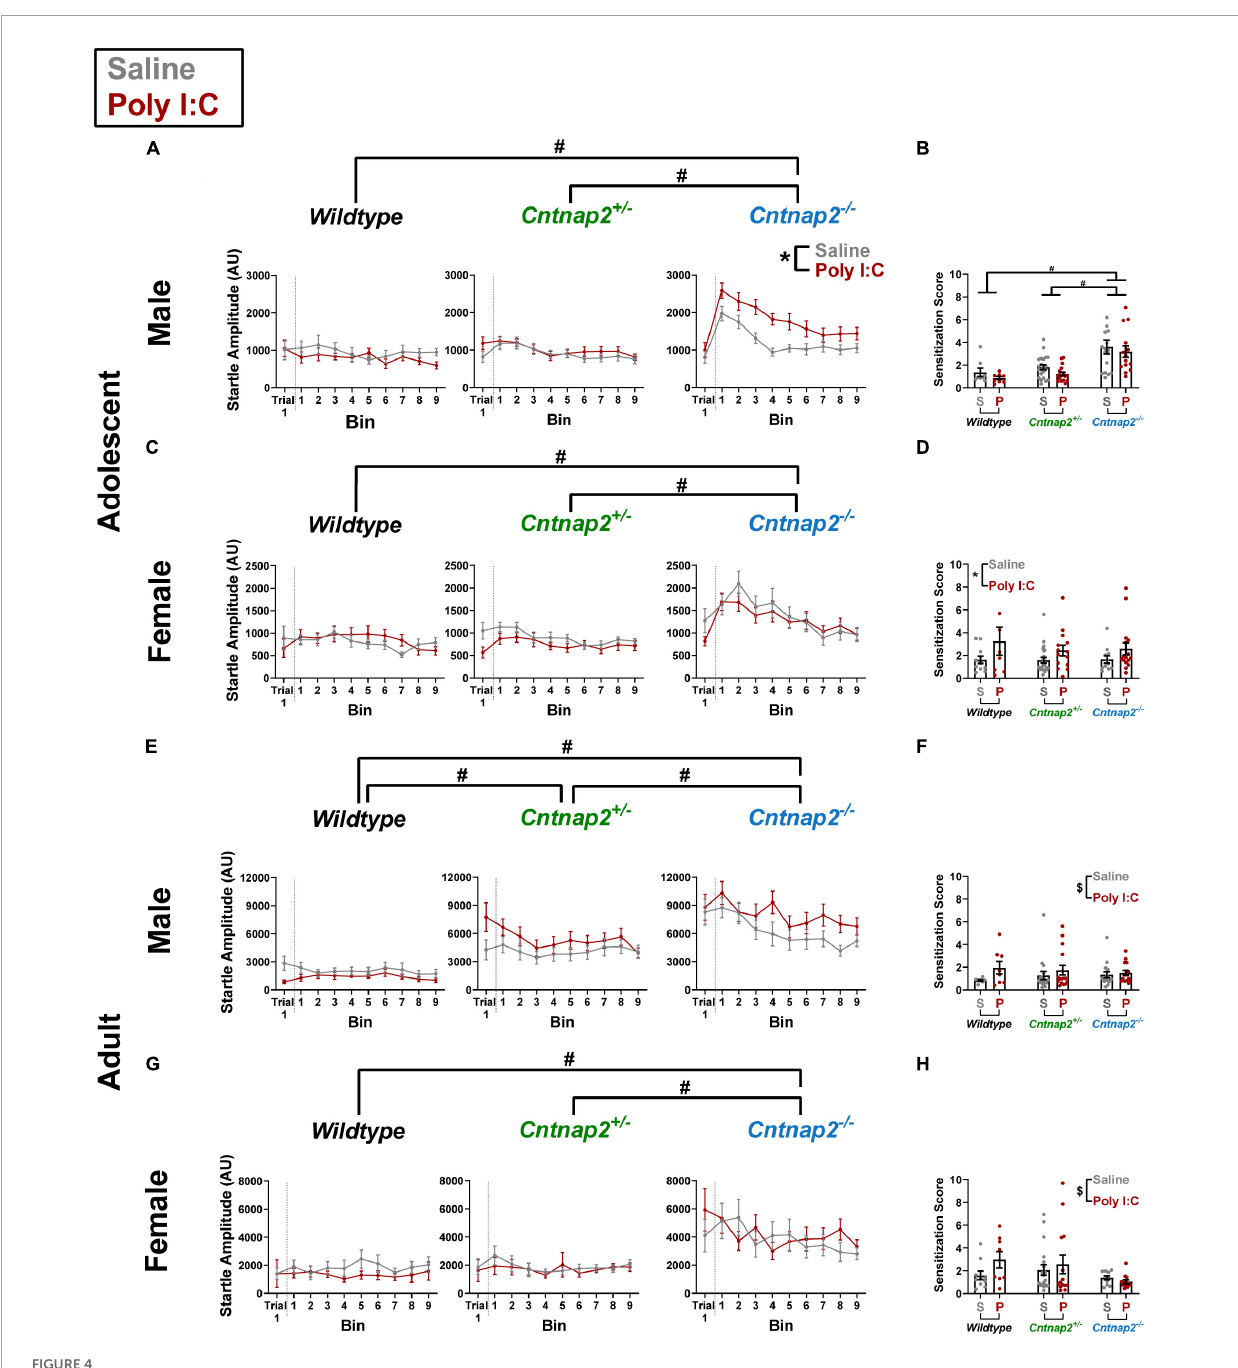
FIGURE4 Independent and synergistic effects of Cntnap2 knockout and Poly I:C MIA on sensitization of startle that manifest in an age, sex, and measurement-specific manner. (A) Adolescent Cntnap2 − / − males show increased startle reactivity compared to both Cntnap2 + / − and WT males across the entire session (adjusted p < 0.001 for both comparisons; independent genotype effect indicated by the # symbol). In addition, Cntnap2 − / − Poly I:C males show increased startle reactivity compared to Cntnap2 − / − saline males ( p < 0.001; synergistic genotype-MIA effect indicated by the ∗ symbol). (B) Sensitization scores show that only the independent genotype effect remains after normalizing the baseline startle response amplitude (adjusted p < 0.001; indicated by the # symbol). (C) Adolescent Cntnap2 − / − females how increased startle reactivity compared to both Cntnap2 + / − and WT females across the entire session (adjusted p < 0.001 for both comparisons; independent genotype effect indicated by the # symbol). (D) Adolescent Poly I:C females show increased sensitization scores compared to adolescent saline females regardless of genotype ( p = 0.04; indicated by the ∗ symbol). (E) Adult Cntnap2 − / − and Cntnap2 + / − males both show increased startle reactivity compared to WT males across the entire session (adjusted p < 0.001 for both comparisons; independent genotype effect indicated by the # symbol). (F) Genotype does not alter sensitization scores in adult males, but Poly I:C offspring sensitize more than saline offspring regardless of sex and genotype ( p = 0.047 indicated by the $ symbol). (G) Adult Cntnap2 − / − females how increased startle reactivity compared to both Cntnap2 + / − and WT females across the entire session (adjusted p < 0.001 for both comparisons; indicated by the # symbol). (H) Genotype does not alter sensitization scores in adult females, but Poly I:C offspring sensitize more than saline offspring regardless of sex and genotype ( p = 0.047 indicated by the $ symbol). Data are shown as mean ± standard error. For information on sample sizes for each group, please see Table 1